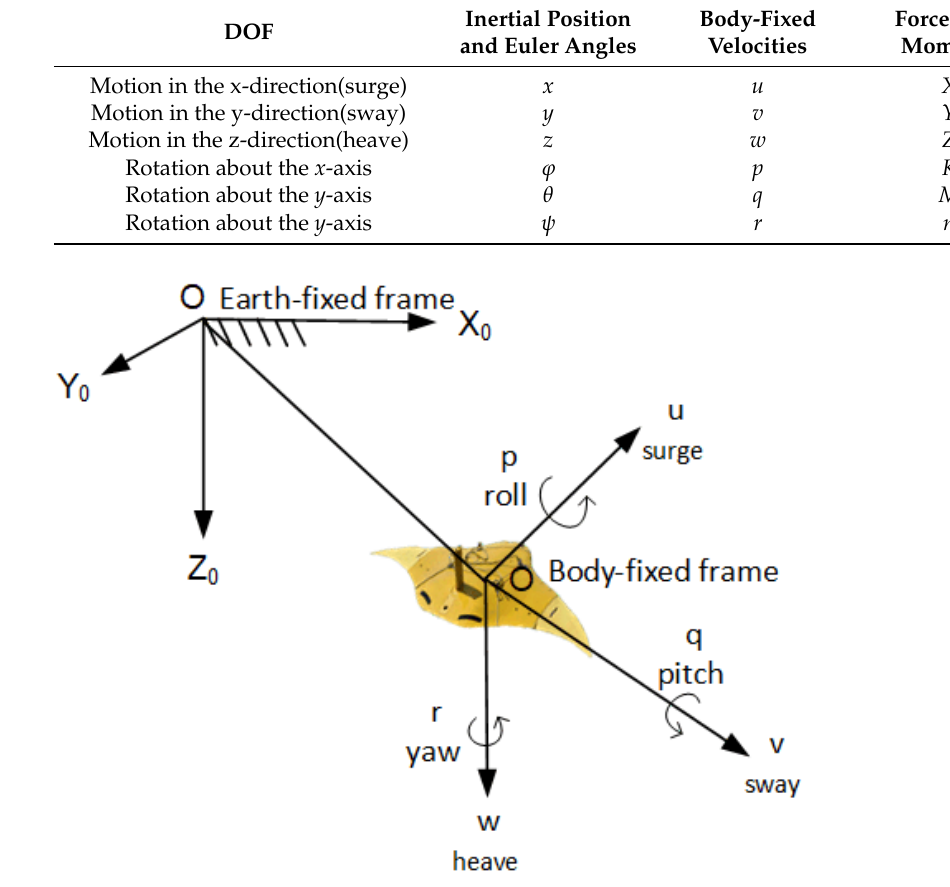
Figure 3. Earth-fixed (inertial) reference and body-fixed reference frames.